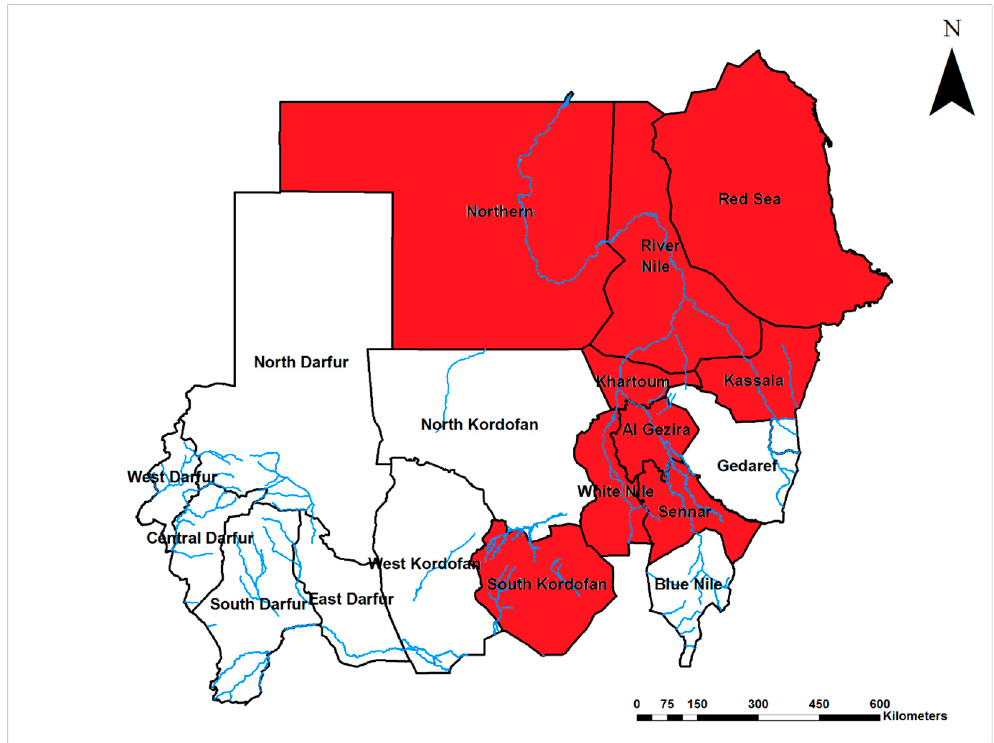
Figure 6. Map of Sudan showing the prevalence of Rift Valley fever virus infections (Red).